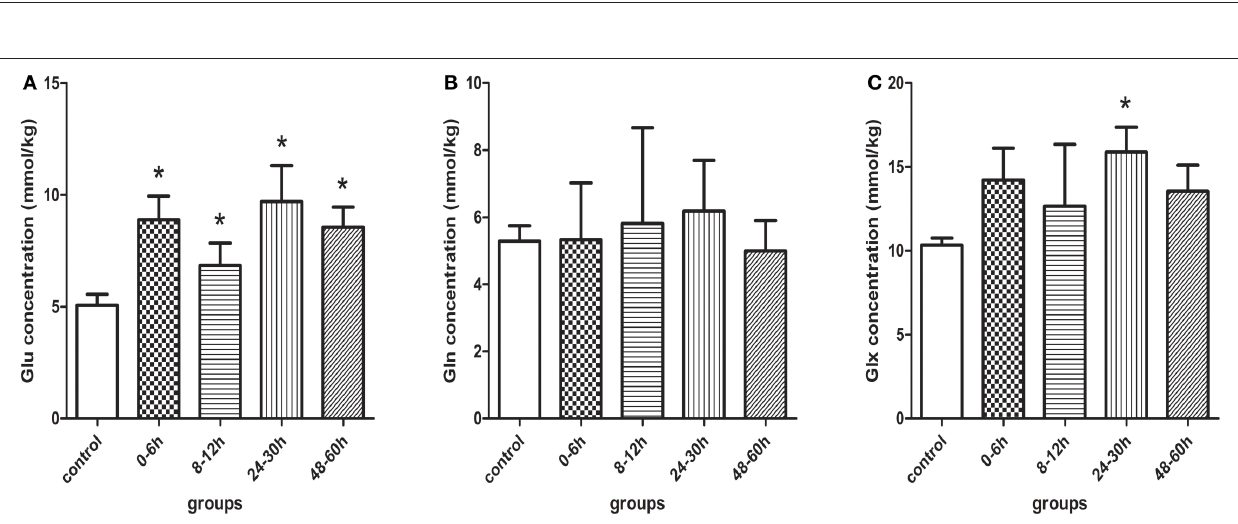
Frontiers in Physiology | www.frontiersin.org